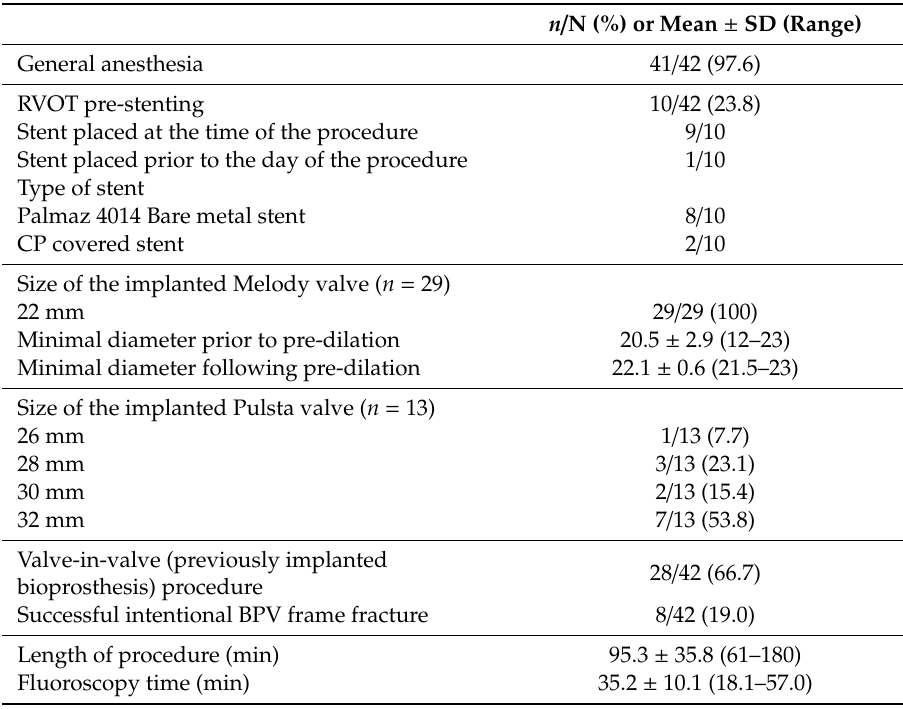
Table 2. Procedural